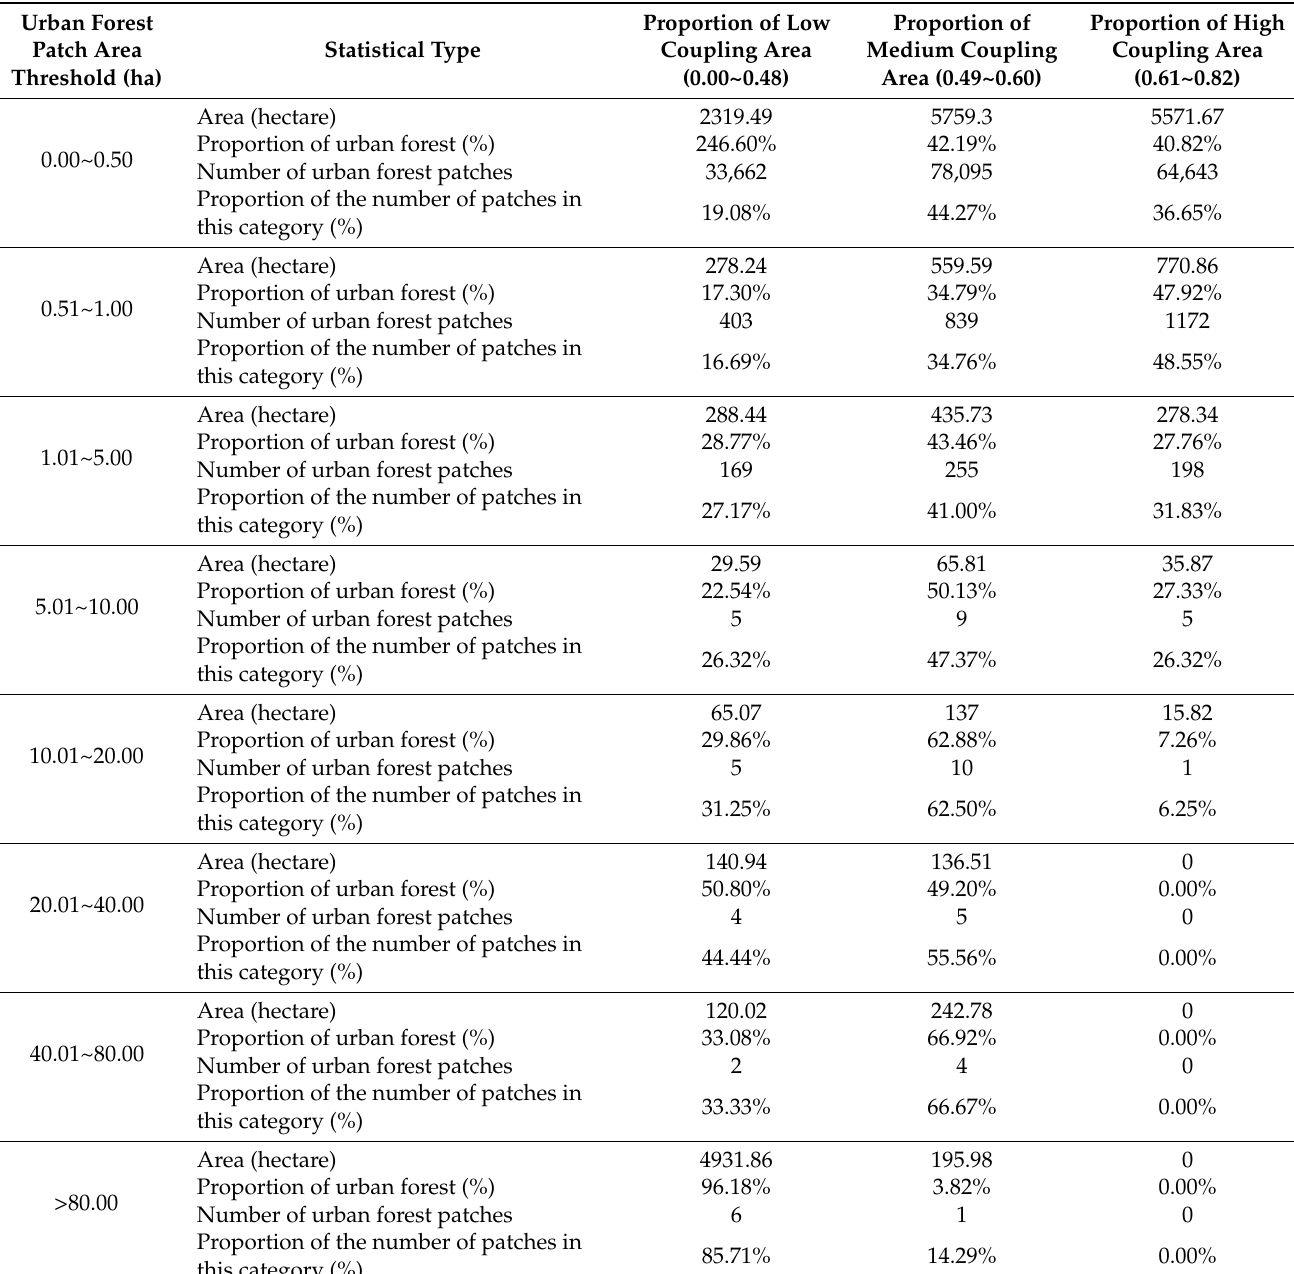
Table 8. Statistics of different urban forest patch area thresholds for the synergy of biodiversity conservation and recreational